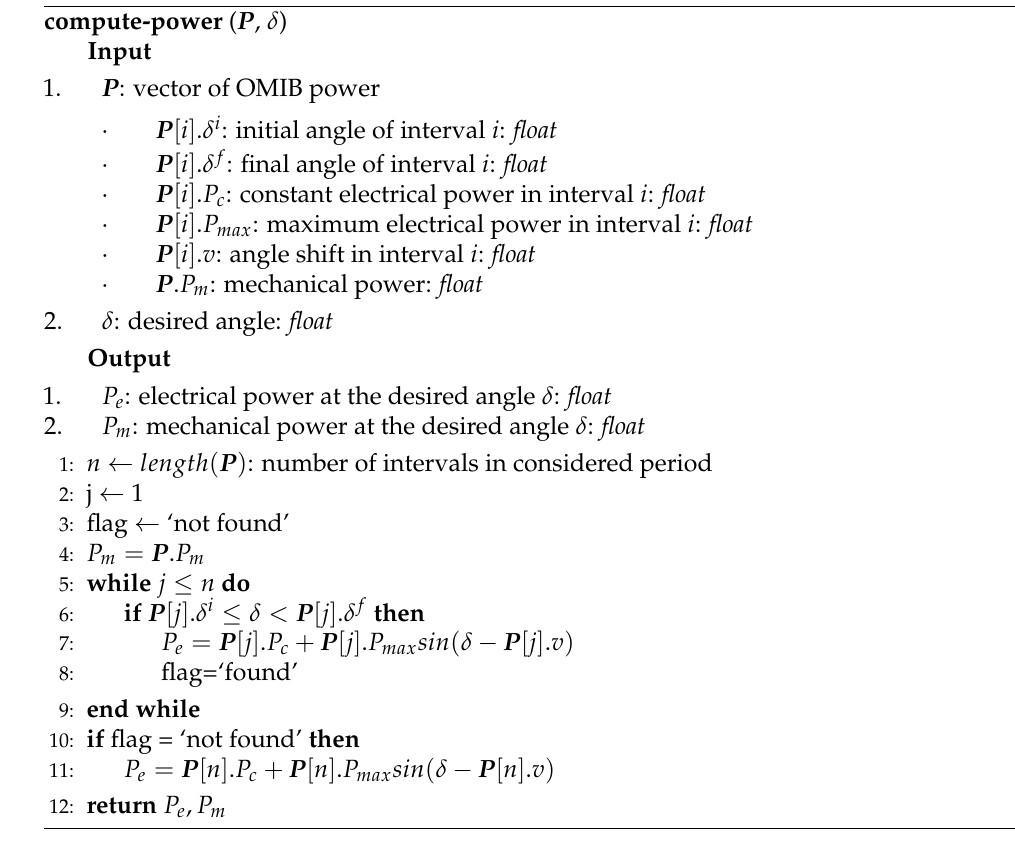
Algorithm A4 Finding electrical and mechanical powers at any desired angle δ